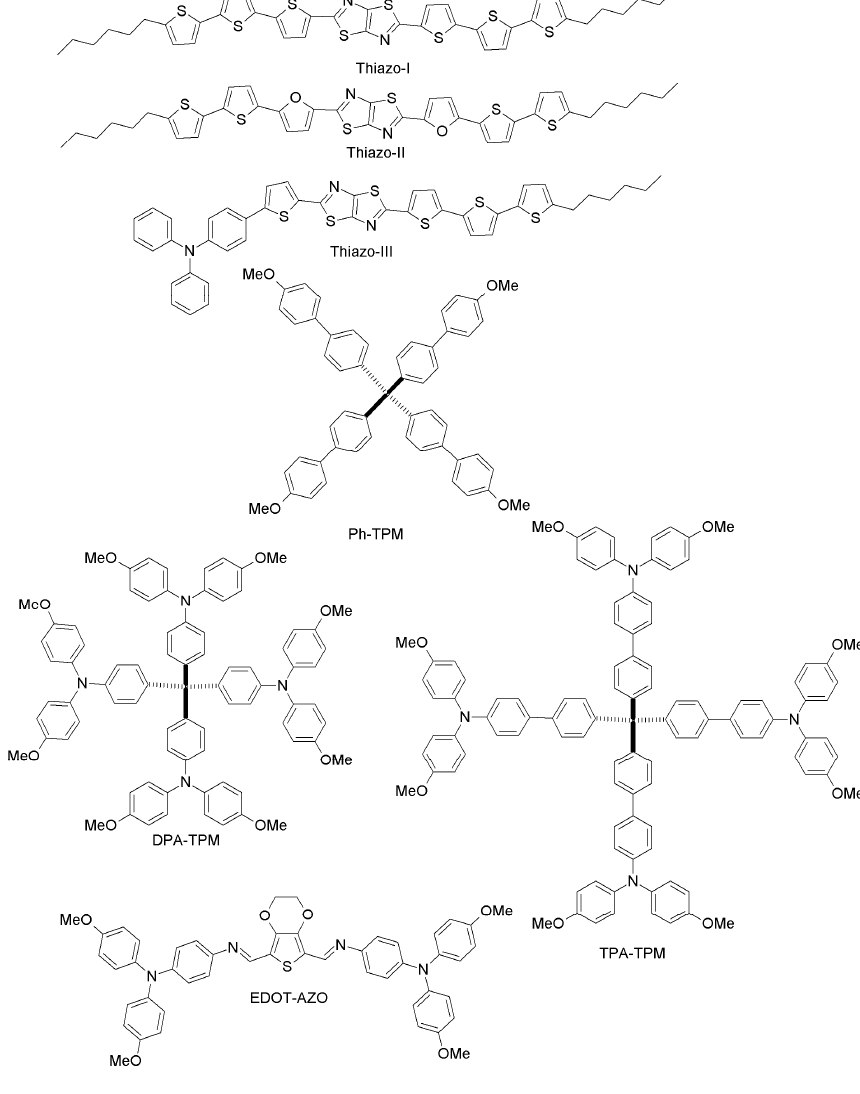
Figure 19. Other organic HTMs (2).